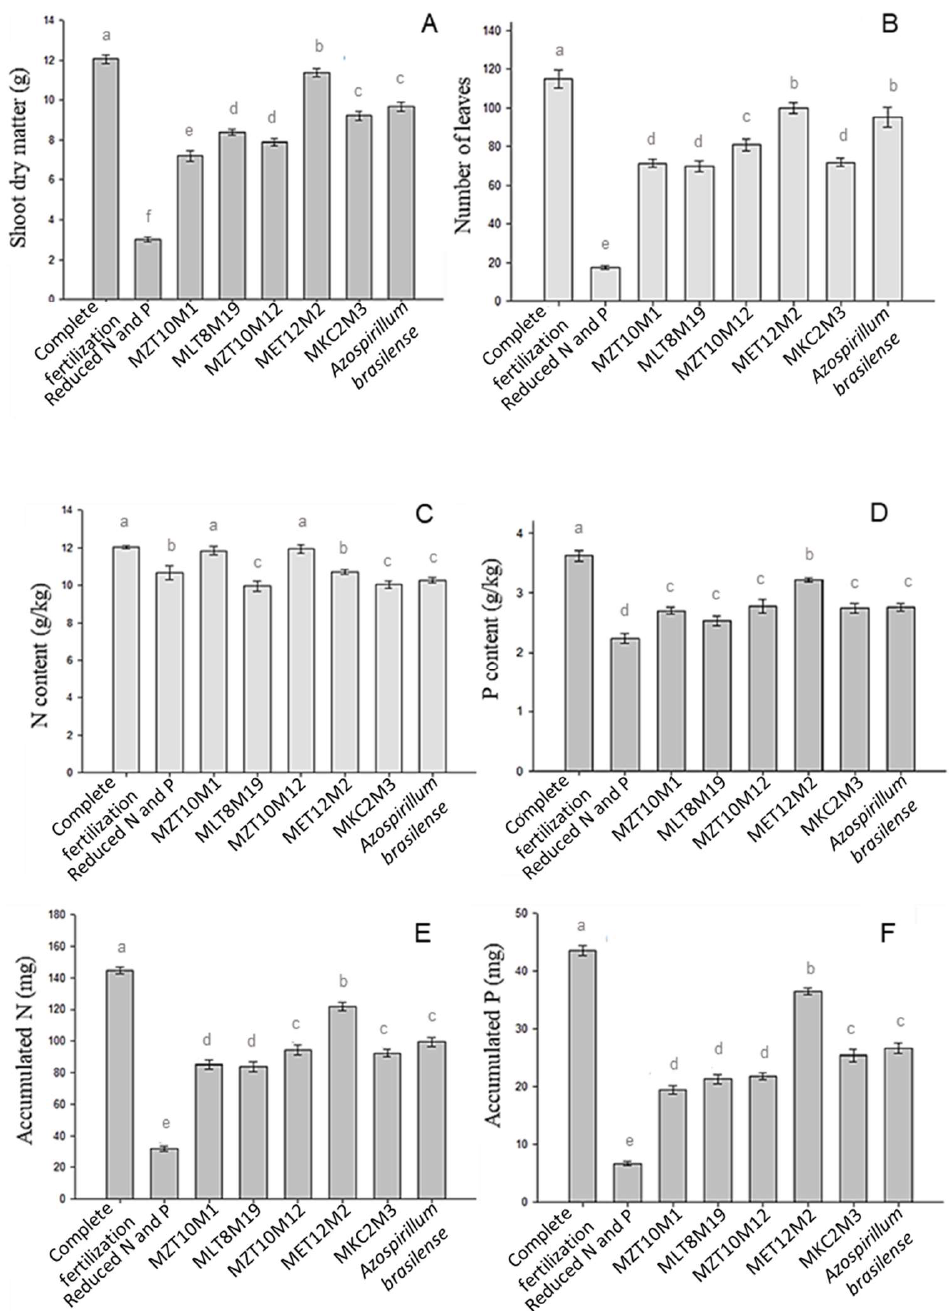
Figure 8. Plant dry matter ( A ), number of leaves ( B ), leaf N content ( C ), leaf P content ( D ), accumulated N ( E ), and accumulated P ( F ) of plants uninoculated or inoculated with in vitro selected endophytic bacteria. Means represented by the same letter do not differ significantly by the Scott–Knot test at 5% probability.